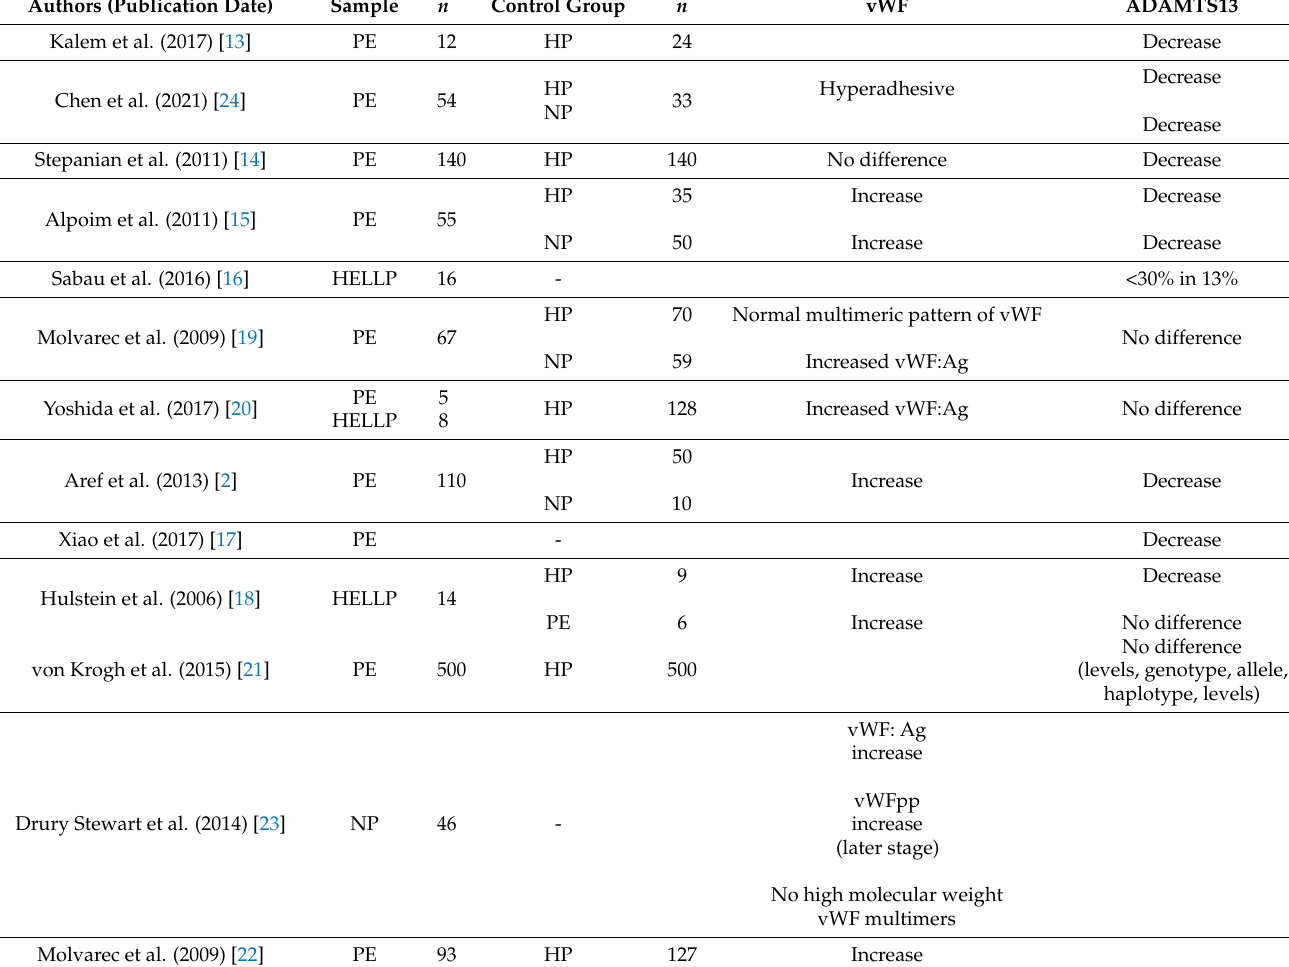
Table 1. Bibliographic data concerning the relationship between vWF/ADAMTS13 in